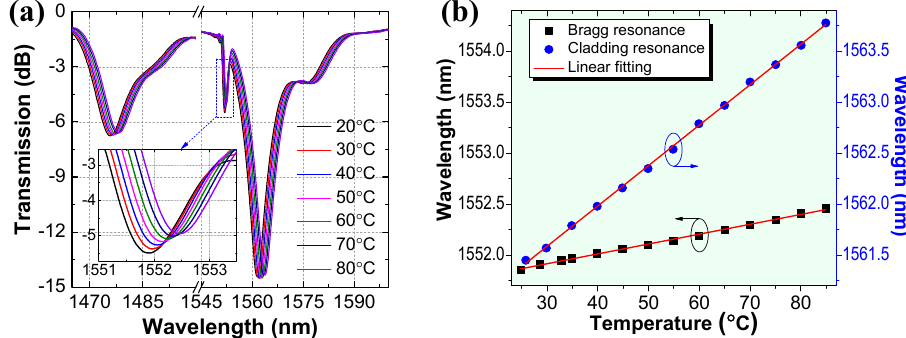
Figure 3. ( a ) Spectral evolution with the temperature; ( b ) temperature responses of Bragg resonance and cladding mode resonance of the hybrid grating.